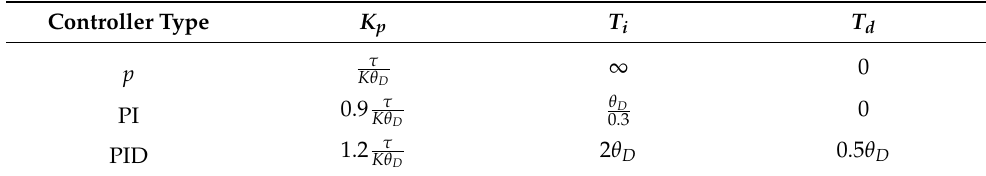
Table 1. Ziegler and Nichols’ tuning rules.